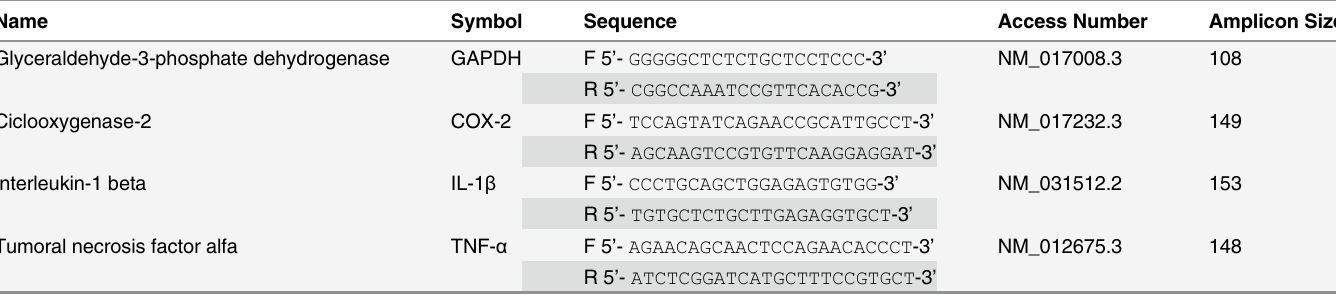
Table 1. Category and description of primer sequences used according to the National Center for Biotechnology Information (NCBI).